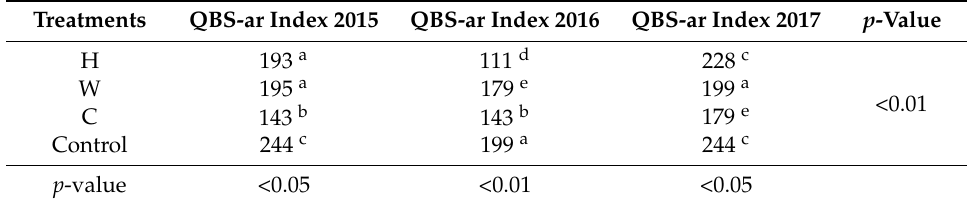
Table 13. Results of the Kruskal–Wallis and Tukey test for Soil Biological Quality (QBS-ar) index data (df 3, 144; median), difference tested between disturbed, undisturbed, and control soil.